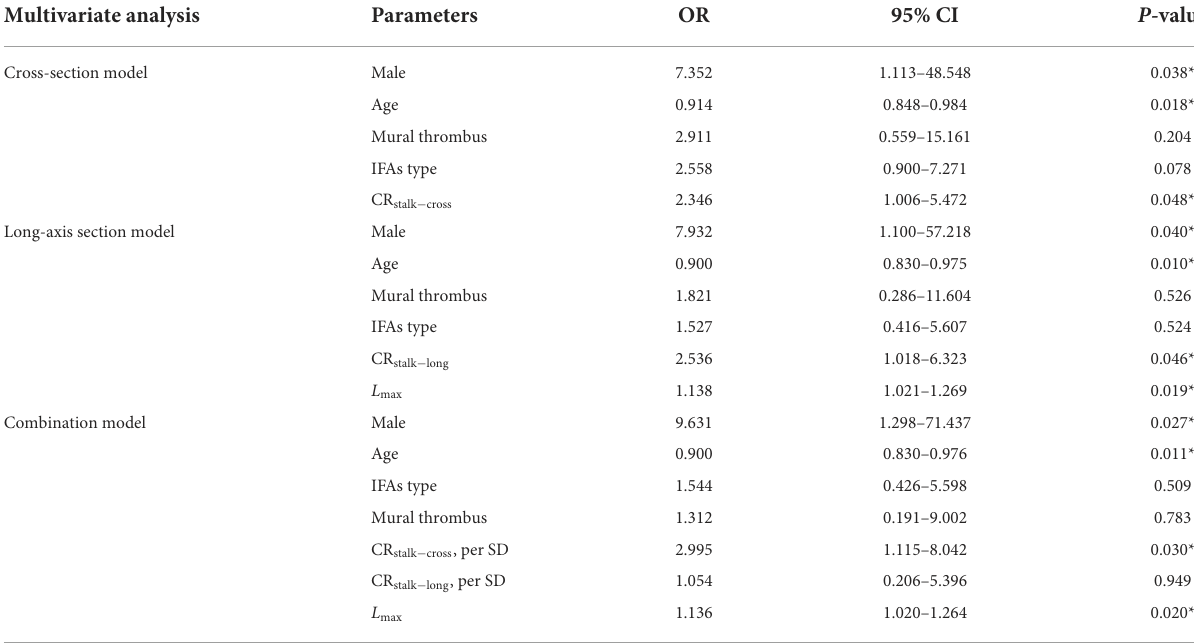
TABLE 3 Three models of multivariate logistic regression analysis for risk factors associated with aneurysmal symptoms. Multivariate analysis